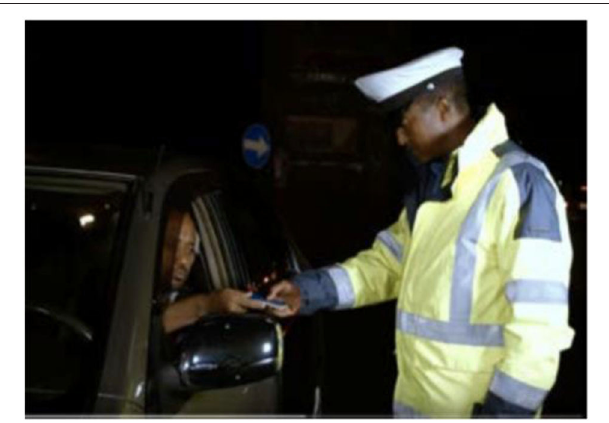
FIGURE 3 | Image from PSA